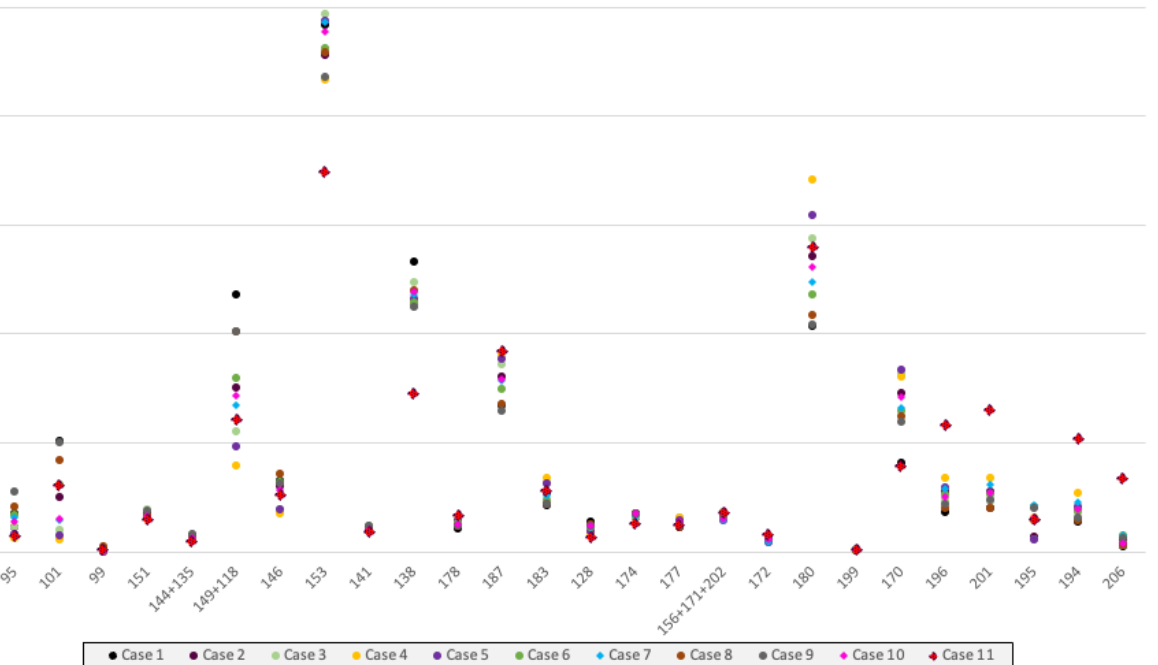
Figure 4. Percentage composition of the polychlorinated biphenyls (PCBs) divided by chlorine con- tent (Penta-CBs, Hexa-CBs, Hepta-CBs, Octa-CBs, Nona-CBs) on Total PCBs found in blubber of the different specimens of T. truncatus and present in Arochlor 1260.